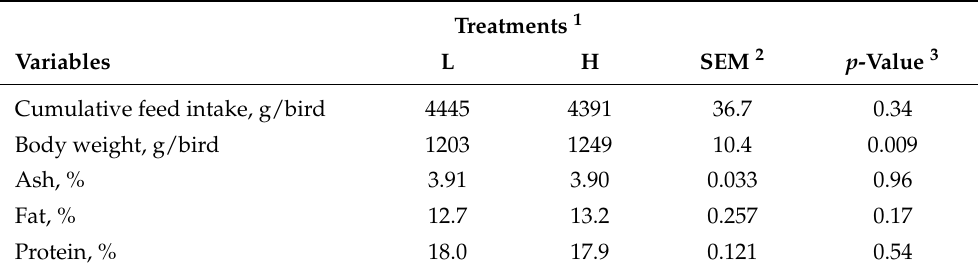
Table 3. Performance and body composition of pullets at 18 weeks of age, fed two levels of balanced protein